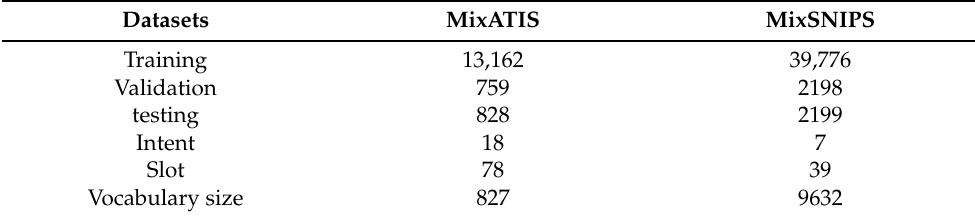
Table 1. Statistics of two public